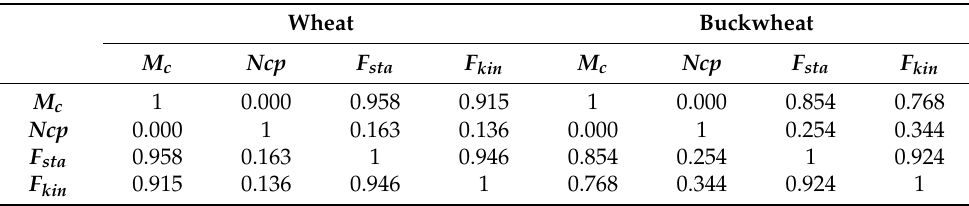
Table 2. Correlation matrixes for both materials ( R 2 ).